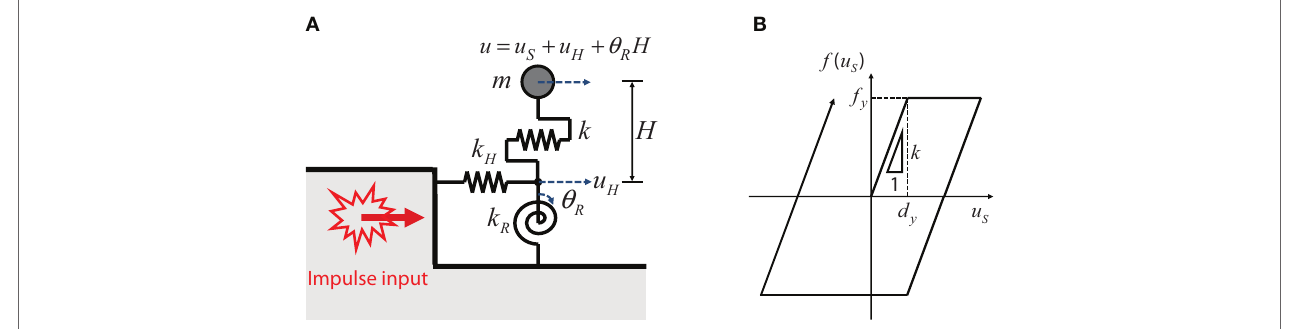
FigUre 5 | simplified swaying-rocking model: (a) model parameters and (B) restoring force